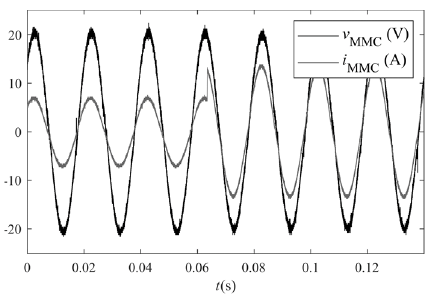
Figure 17. MMC output voltage and current for a step change in the load.